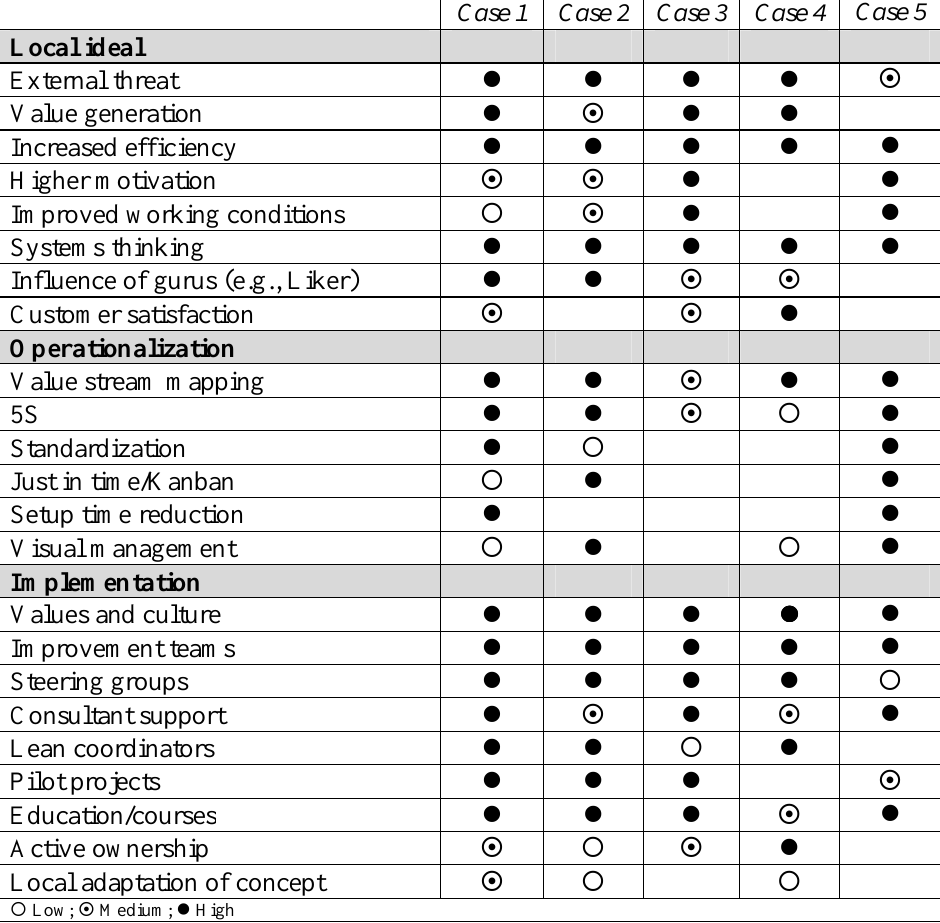
Table 1 − Comparison of cases